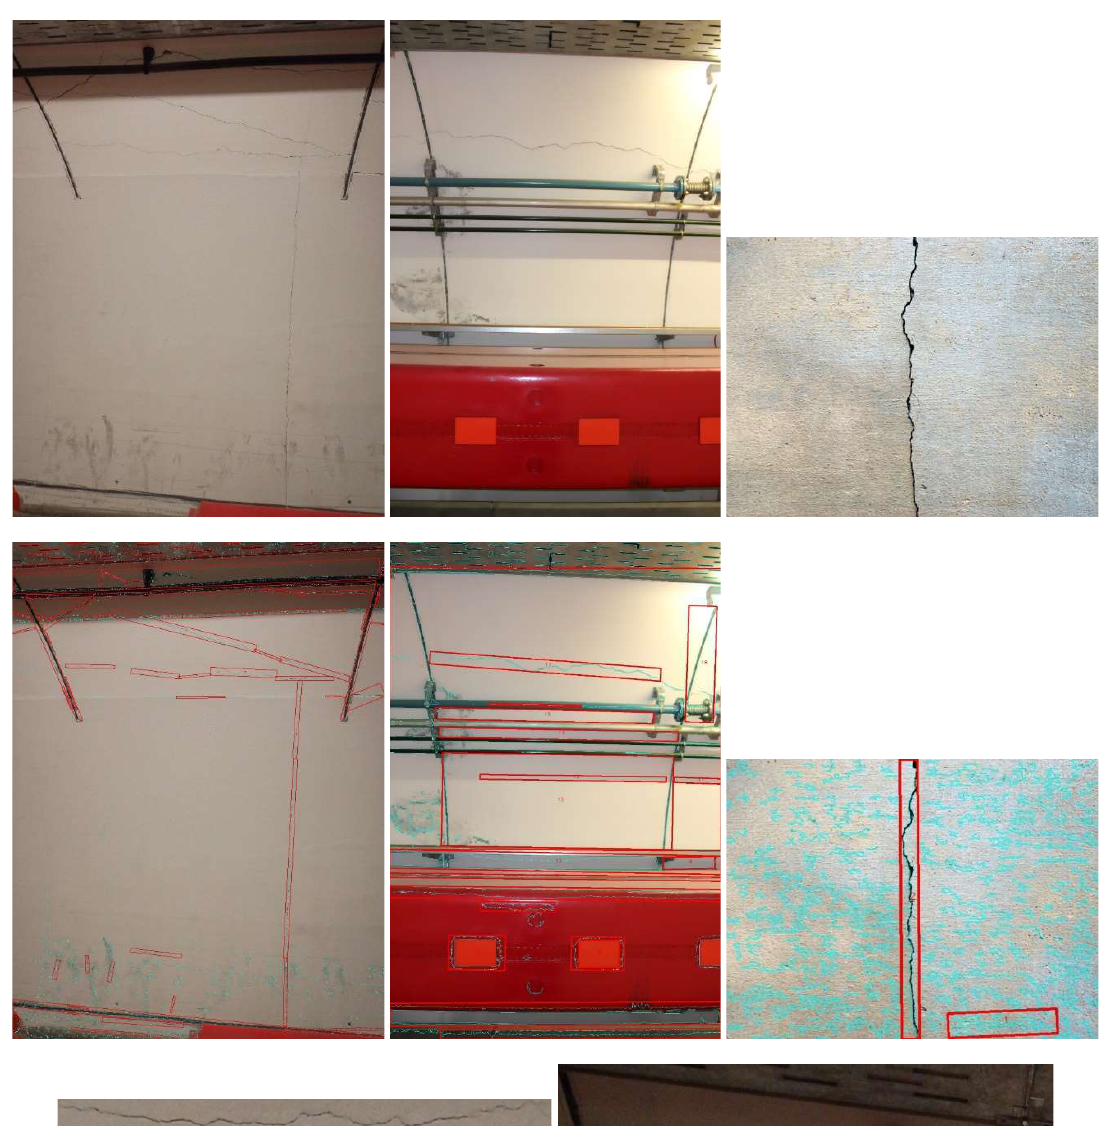
Figure 5: original images (top), image processing output (middle), example of cropped crack from the whole image